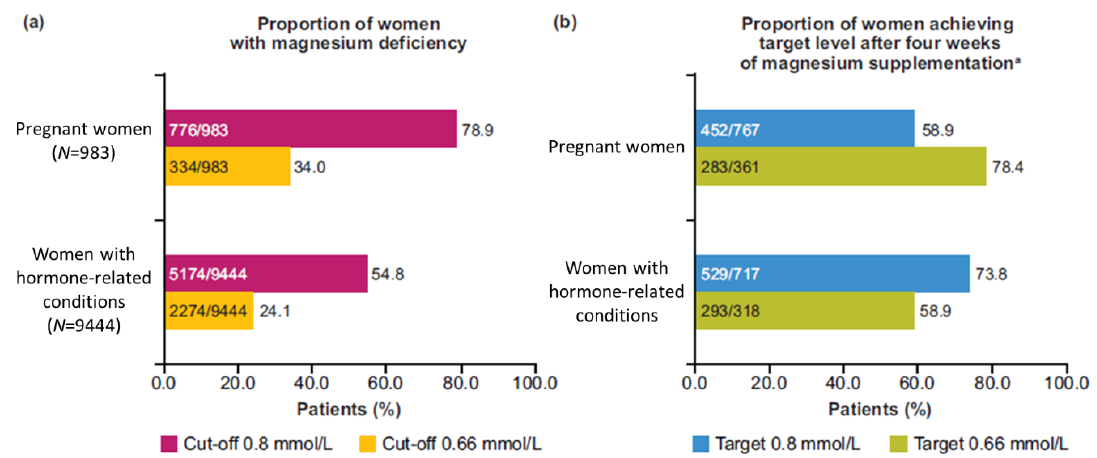
Figure 2. Prevalence and clinical management of magnesium deficiency: ( a ) Proportion of women with magnesium deficiency at Visit 1; ( b ) Proportion of women achieving the target level after four weeks of magnesium supplementation. a Includes women who had a magnesium serum level below the corresponding target at baseline.